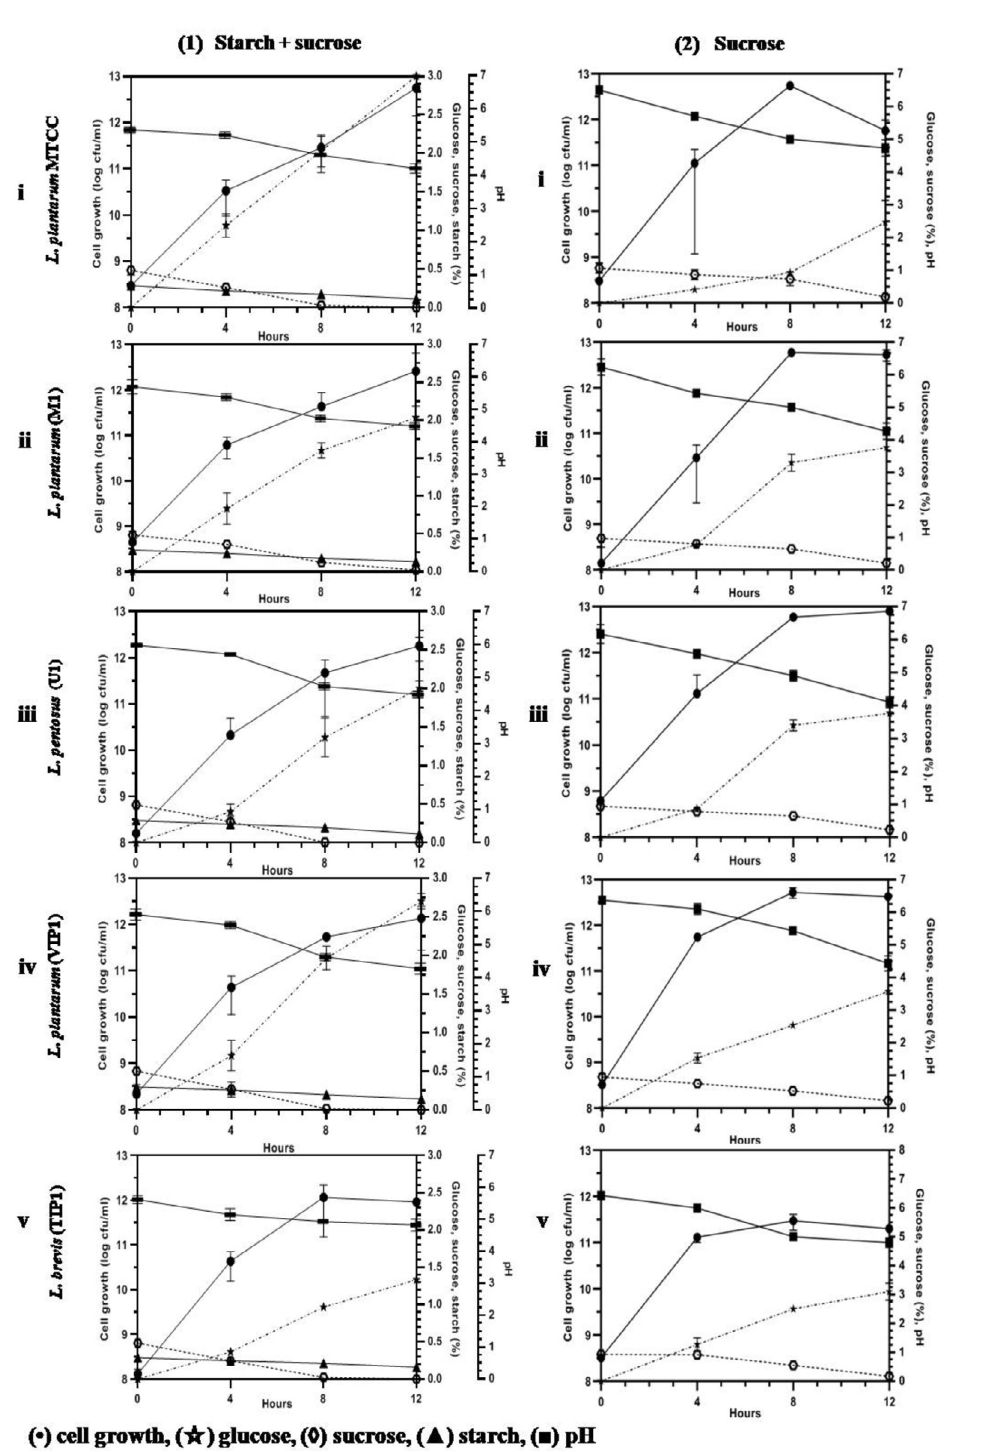
Fig. 2A. (Kinetics of different carbohydrate utilization using starch + sucrose (1), and sucrose (2), during fermentation with Lactobacillus isolates and reference strain in mMRS